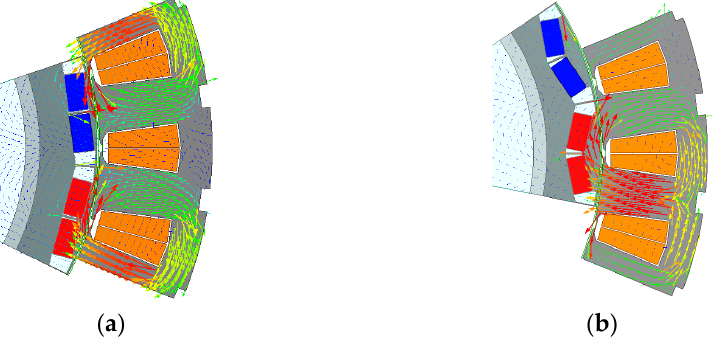
Figure 5. Magnetic flux density plot depending on magnet type: ( a ) Bar type, ( b ) V-shaped type.